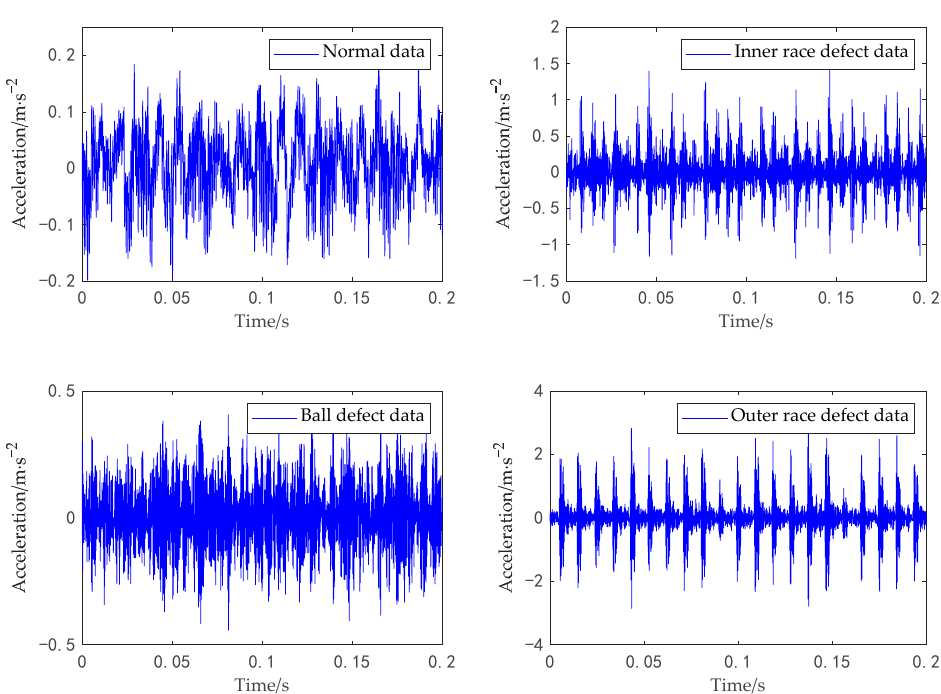
Figure 4. Bearing test platform.